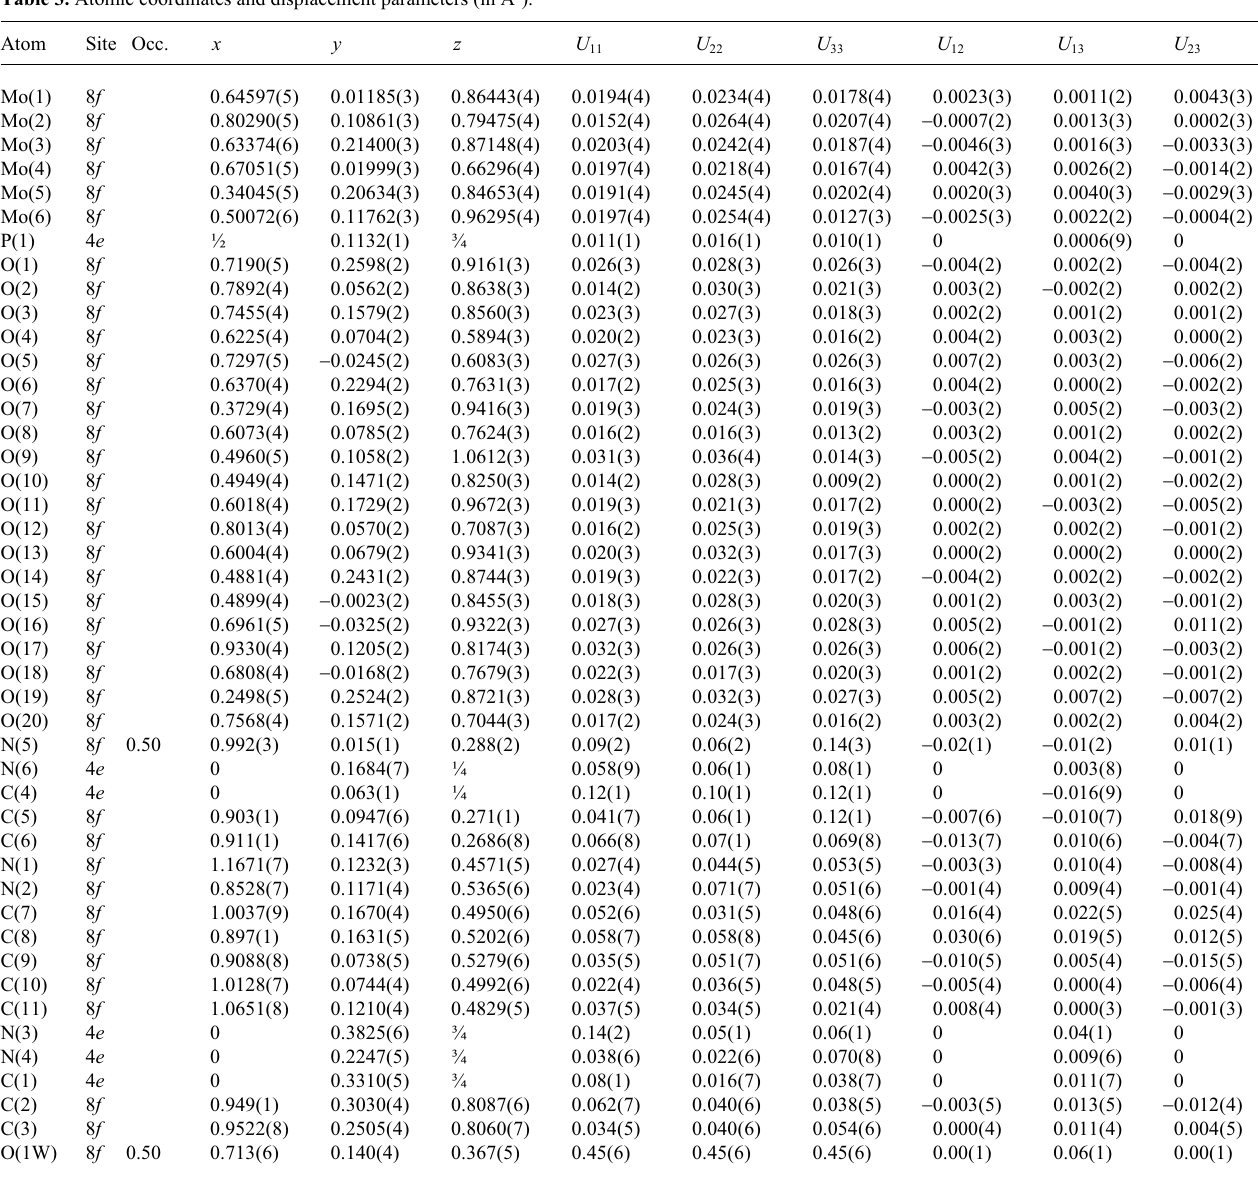
Table 3. Atomic coordinates and displacement parameters (in Å 2 ).